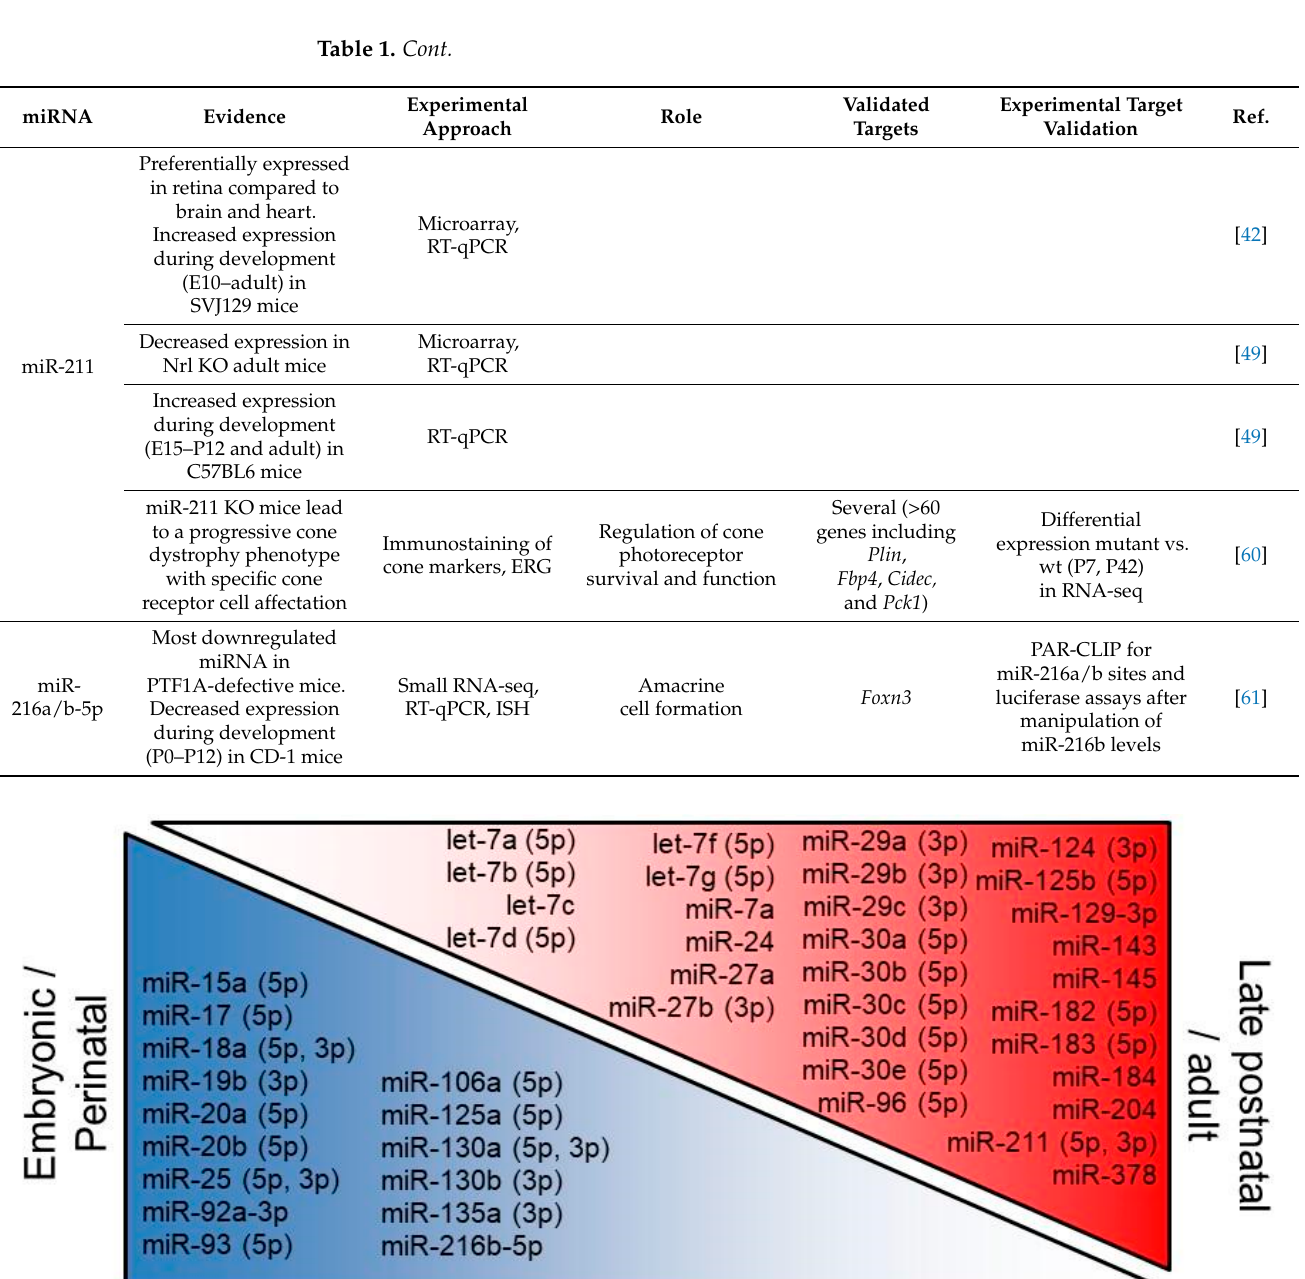
Figure 2. Summary of the most consistent changing miRNAs in miRNome research (blue, downreg- ulated; red, upregulated) that at least have been retrieved in two of the following studies: [39,41– 43,46,47,49,51,55,56,58,61–63]. The arm (5p or 3p) is indicated when specifically reported.